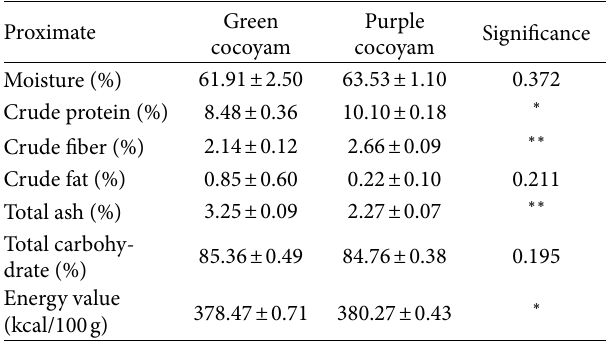
Table 1: Proximate composition of green- and